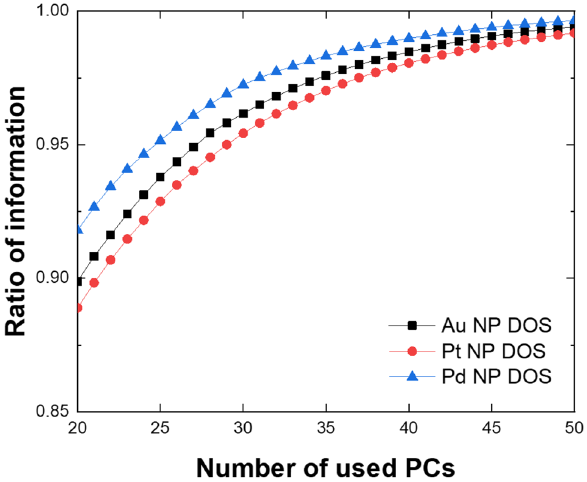
Figure 4. PCA of Au, Pt, and Pd NPs. The ratios of information for DOS patterns of Au, Pt, and Pd NPs DOSs in PCA analysis. Here, the ratio of Pd NP is higher than those of Au and Pt